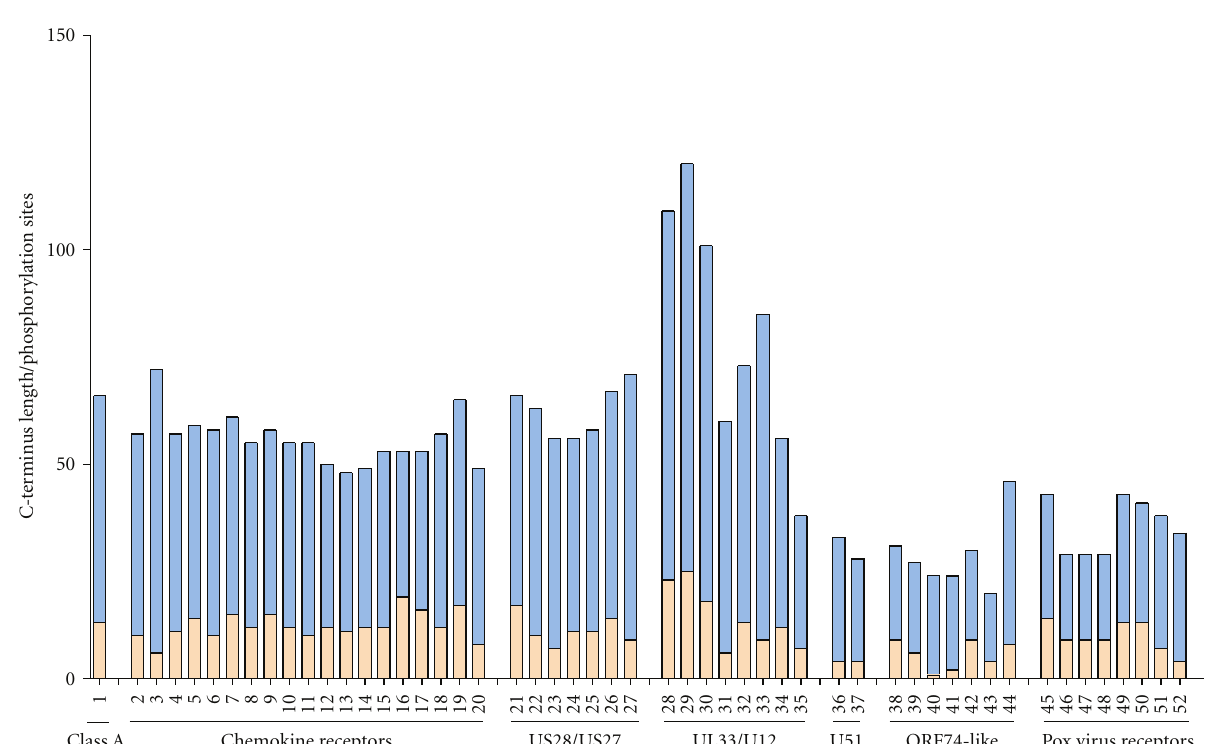
Figure 3: Relative sequence length and putative phosphorylation sites of the C-terminal region of class A 7TM receptors, chemokine receptors and virus-encoded chemokine receptors. The vertical axis displays the number of amino acids of the C-terminus (blue), defined as being after the highly conserved proline of the NPxxY-motif, and the number of serine, threonine and tyrosine in this region (beige). The horizontal axis displays the average of 334 non-olfactory class A 7TM receptors (1), the chemokine receptors (2–20) and the viral chemokine receptors (21–52). For further information about specific receptors and GenBank accession number please see Table